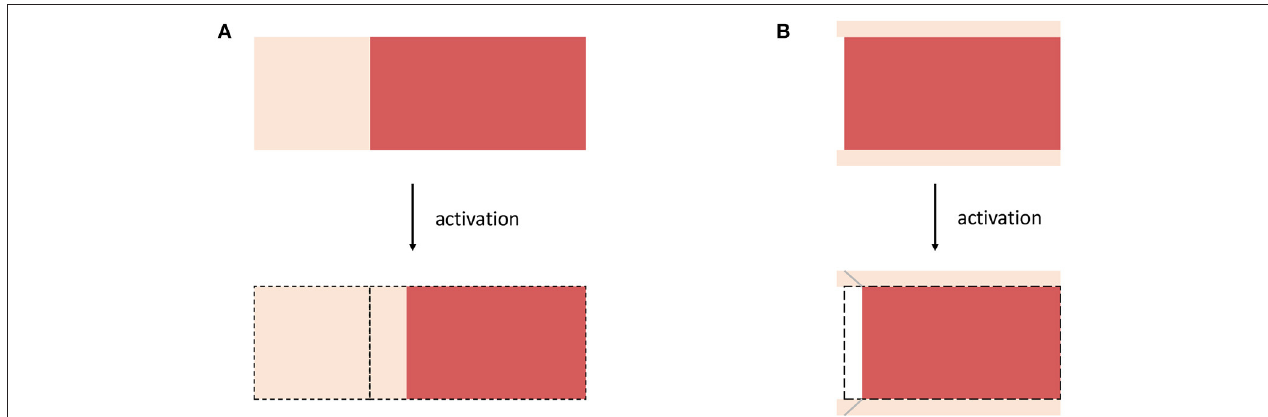
FIGURE 3 | Schematic drawings for (A) Example 3, considering a muscle fiber (red) which is serially arranged with extracellular connective tissue (bright color) and (B) Example 4 considering a non-spanning muscle fiber (red) embedded in (thin) sheets of extracellular connective tissue (bright color). For both examples, the structural rearrangement caused by the activation of the muscle fibers are